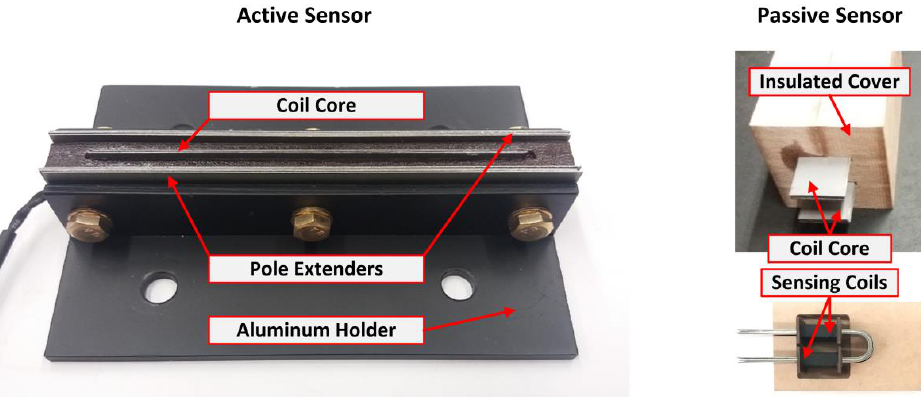
Figure 2. Design configuration of the sensors—Active sensor with the sensing coil between pole extenders and Passive sensor with two coils configuration.